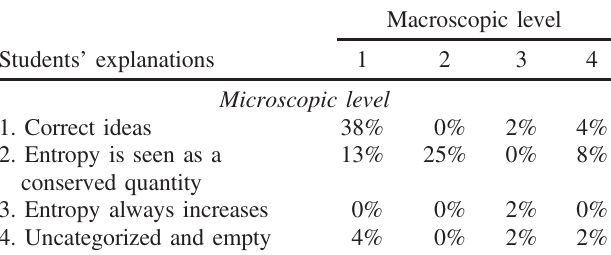
TABLE V. Cross tabulation of students ’ explanations concern- ing changes in entropy and in the number of accessible micro- states for individual objects (items 1a and 2a). N ¼ 48 . Categories 1 – 4 are the same in columns and rows but for macroscopic (columns) and microscopic (rows)